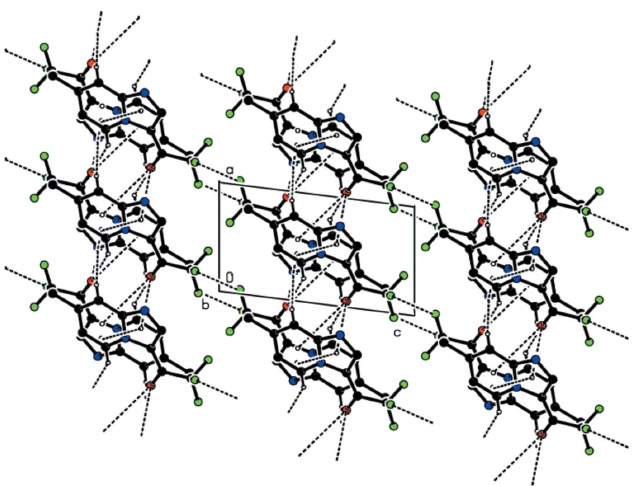
Figure 4 Packing diagram of the title compound, viewed down the b axis showing the C—H (cid:2)(cid:2)(cid:2) O and C—H (cid:2)(cid:2)(cid:2) N hydrogen bonds and the F (cid:2)(cid:2)(cid:2) F and (cid:2) – (cid:2) stacking interactions. Hydrogen atoms not involved in hydrogen bonding are omitted.